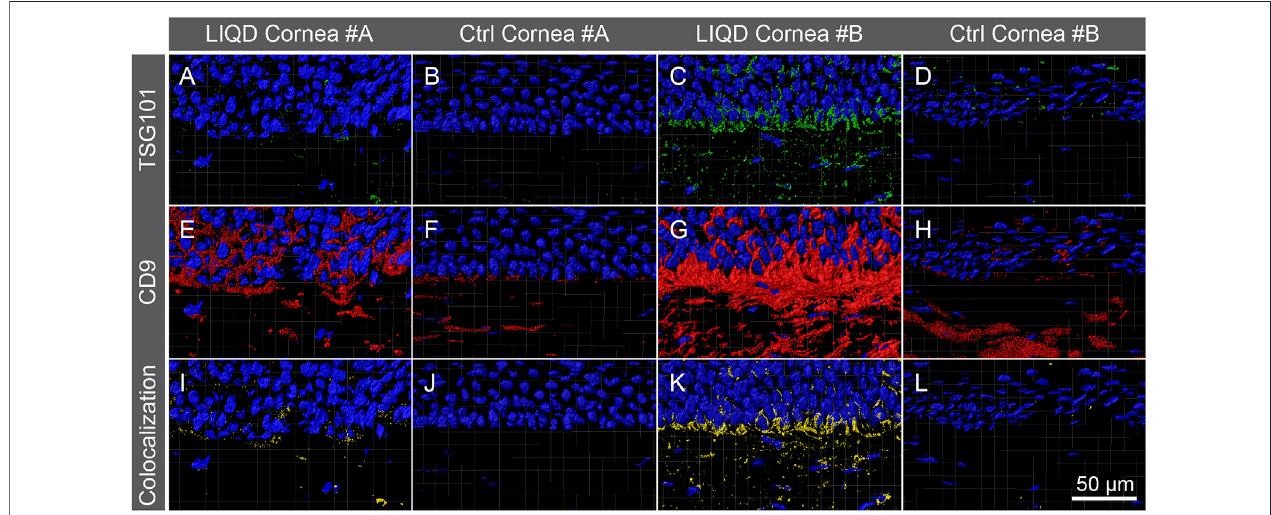
FIGURE 9 | Immuno fl uorescence of the exosomes. TSG101 ( green; A – D) , CD9 ( red; E – H) and colocalization of both ( yellow; I – L) proteins in the epithelial and subepithelialregionsoftheLiQDCornea-implantedandunoperatedcontrolcorneasofbothanimals.SurfacecolocalizationreconstructionofTSG101andCD9showed a greater abundance of exosomes in the basal layer of the epithelium and sub-epithelial layers of the LiQD Cornea-implanted corneas. Colocalization in the unoperated eyes was minimal. Cell nuclei were counterstained with DAPI (blue). Scale bar: 50